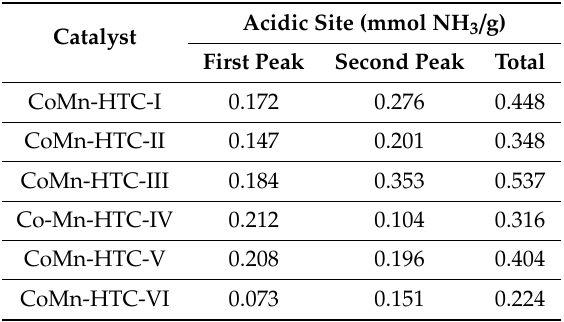
Figure 4. Ammonia temperature-programmed desorption (NH 3 -TPD) profiles of the CoMn-HTC catalysts. Table 2. Surface acidity of CoMn catalysts measured by ammonia temperature-programmed desorption (NH 3 -TPD).